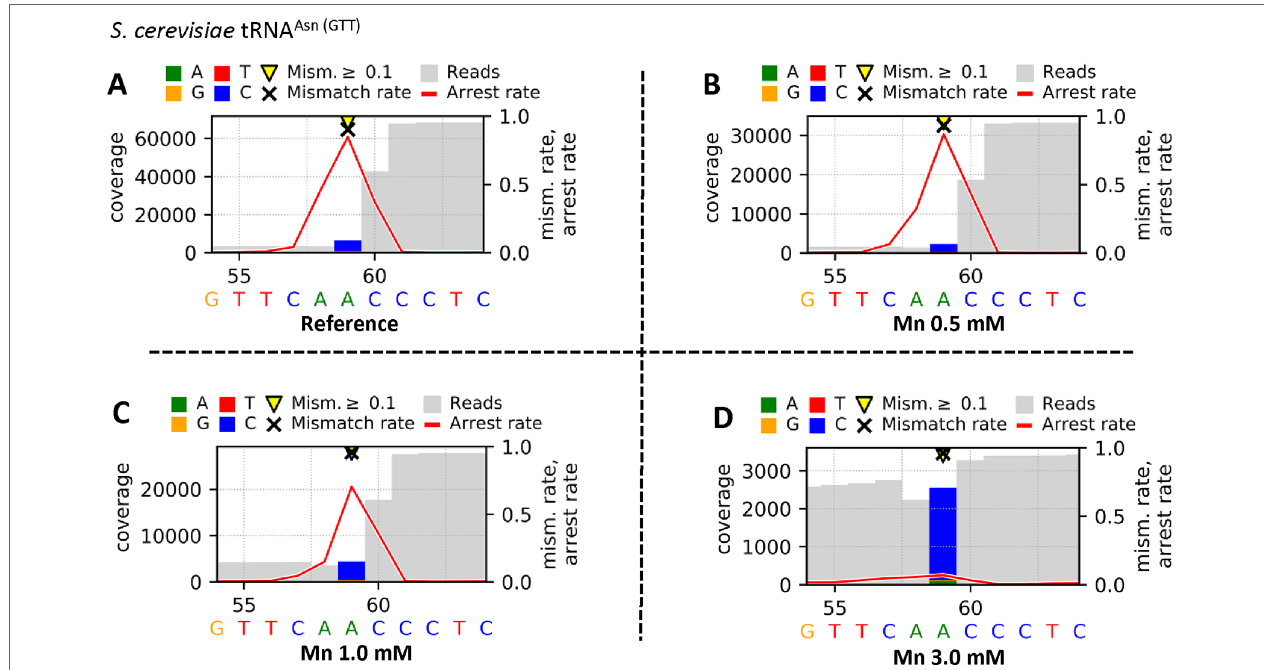
FIGURE 4 | Graphical plots of yeast tRNA Asn (GTT) , which was used for library preparation, visualized by using the additional module Visualize_V3 . The reverse transcription step was performed by using SuperScript ® III Reverse Transcriptase in different reaction buffers. The supplier’s standard reaction buffer (First Strand Synthesis buffer) with Mg 2+ serves as reference (A) , and the tested buffer mixtures differ by increased concentrations of Mn 2+ [0.5 mM (B) , 1.0 mM (C) , 3.0 mM (D) ] as Mg 2+ substitute. Sites with error rates of more than 10% are highlighted with yellow arrows, with colored bars indicating the nature of the reads. Mismatch rates are depicted as black crosses, and arrest rates as red lines. The m1A site is located in the middle of the shown sequence segment at position